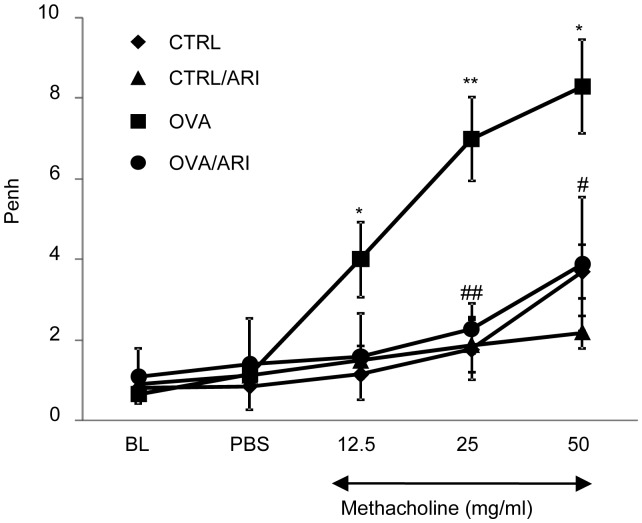
AR inhibition decreases airway hyper-responsiveness in the OVA-challenged chronic asthmatic mice.After 6-weeks of OVA-challenge, the changes in pause of breathing (Penh) were measured by whole-body unrestrained plethysmography using increasing concentration of methacholine. The mice from different experimental and control groups were placed in a barometric chambers and Penh values were determined. Each data point represents mean ± SD from each group (n = 4). *p<0.05 vs. control; **p<0.001 vs control; #
p<0.01 vs OVA-challenged mice; BL, baseline; CTRL, control, ARI, aldose reductase inhibitor, OVA, ovalbumin, PBS, phosphate buffered saline.